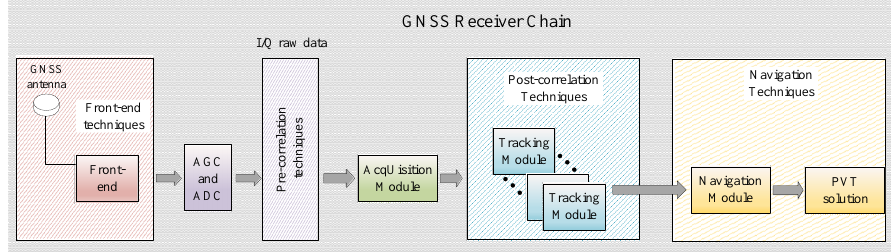
Figure 1. The three domains of a typical GNSS receiver: pre-correlation; post-correlation; and navigation